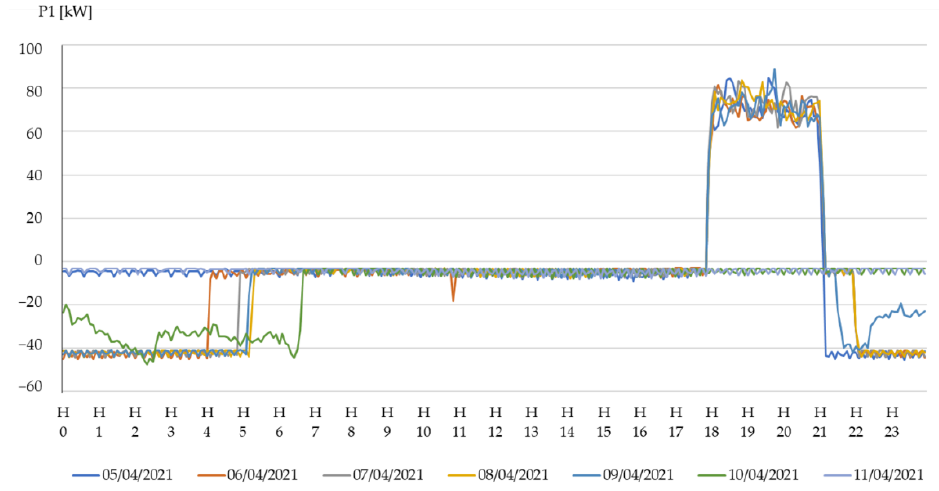
Figure 5. BESS active power flow (P1) measured with meter #1 during the week of 5 April 2021 (kW). The effective BESS energy is calculated by integrating the active power through time